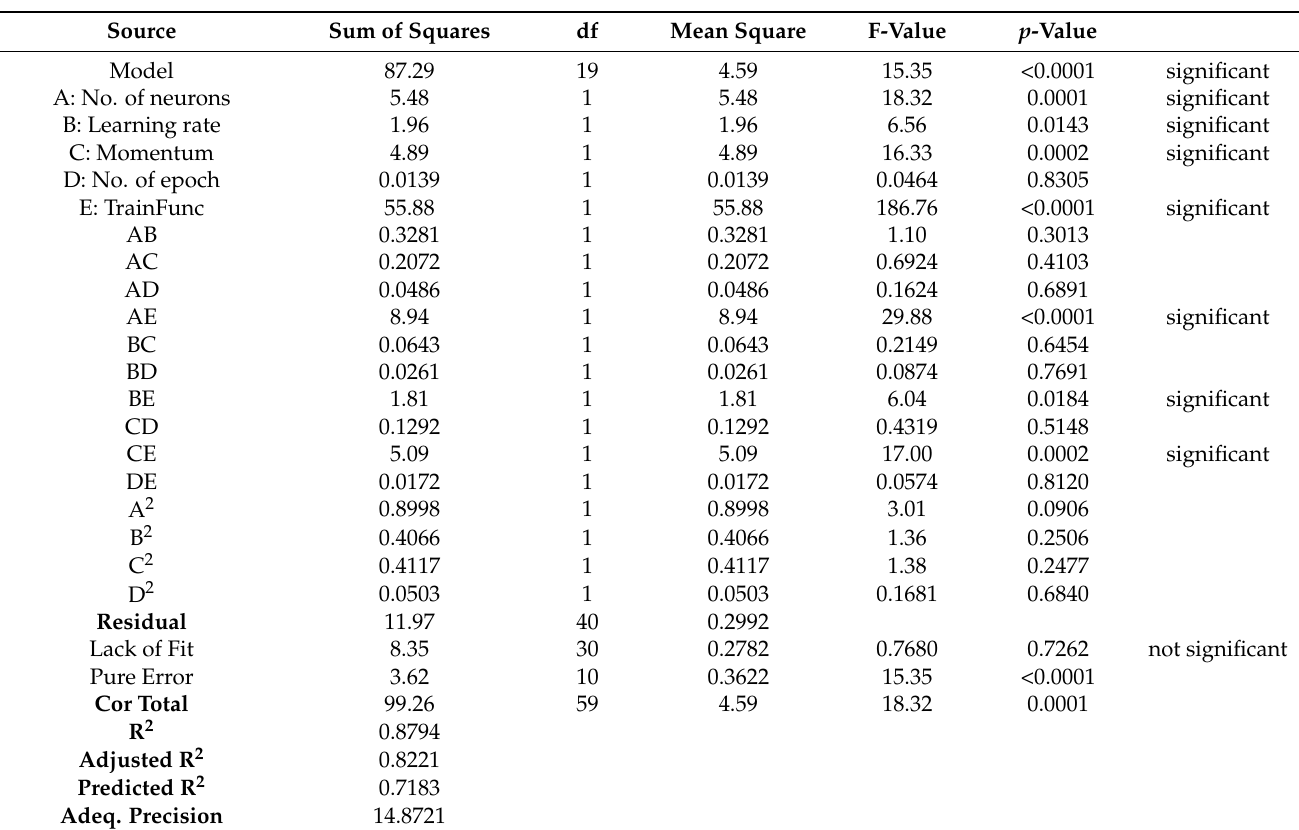
Table 4. Analysis of variance (ANOVA) for the response surface of the quadratic